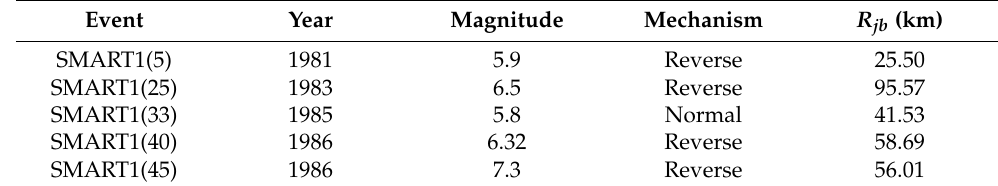
Table 1. Metadata of earthquakes.